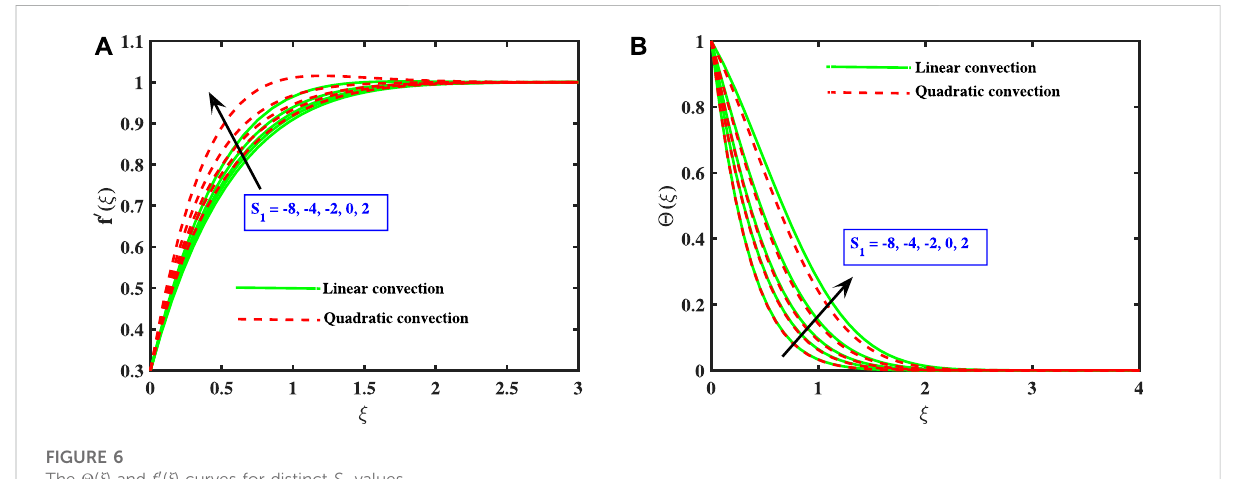
FIGURE 6 The Θ ( ξ ) and f ′ ( ξ ) curves for distinct S 1 values.